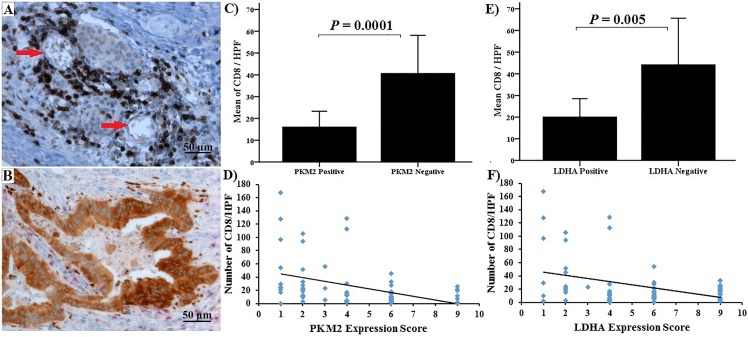
Immunohistochemical staining and correlation between PKM2 and LDHA and CD8+TIL.(A) Well differentiated tumours with negative PKM2 expression had strong infiltration by CD8+ positive T-lymphocytes (x200 magnification). (B) Poorly differentiated tumours strongly positive for PKM2 had sparse infiltration by CD8+ positive T-lymphocytes (x200 magnification). There was a significant negative correlation between CD8+ positive cells and both PKM2 (C) & (D) and LDHA staining (E) & (F).